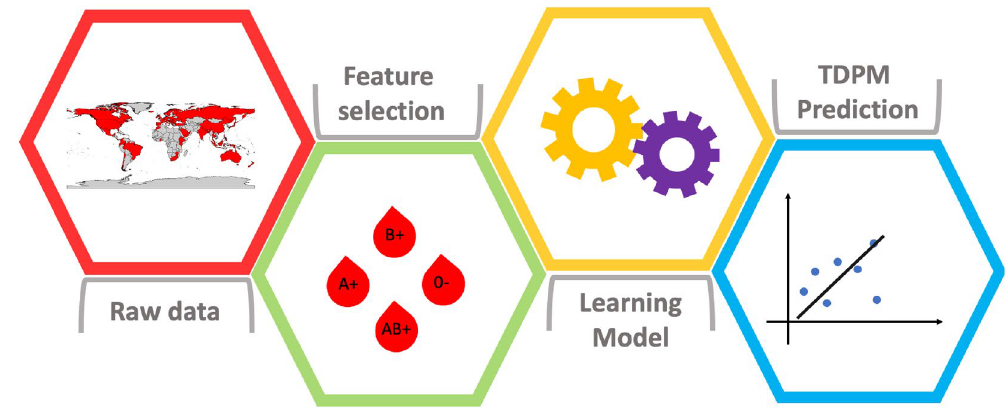
Figure 1. Flowchart of the proposed methodology. We fed the learning algorithm with selected features to forecast the TDPM. Microsoft Power Point was used to generate the